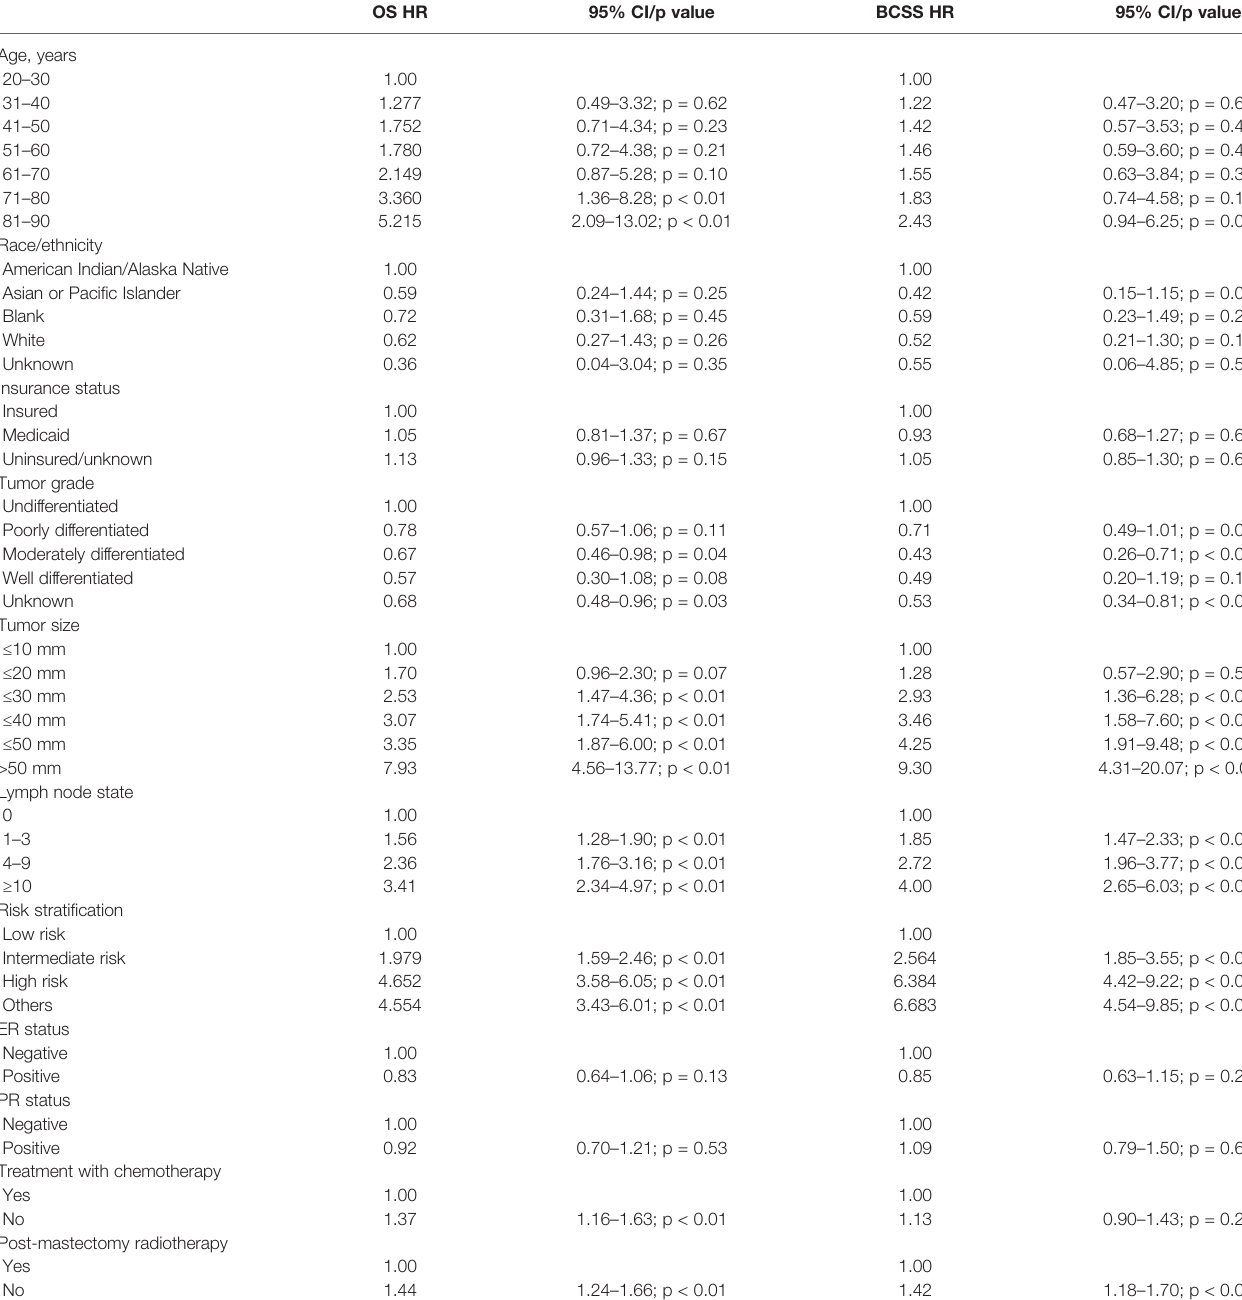
TABLE 3 | Multivariate analyses of OS and BCSS for the MBC after